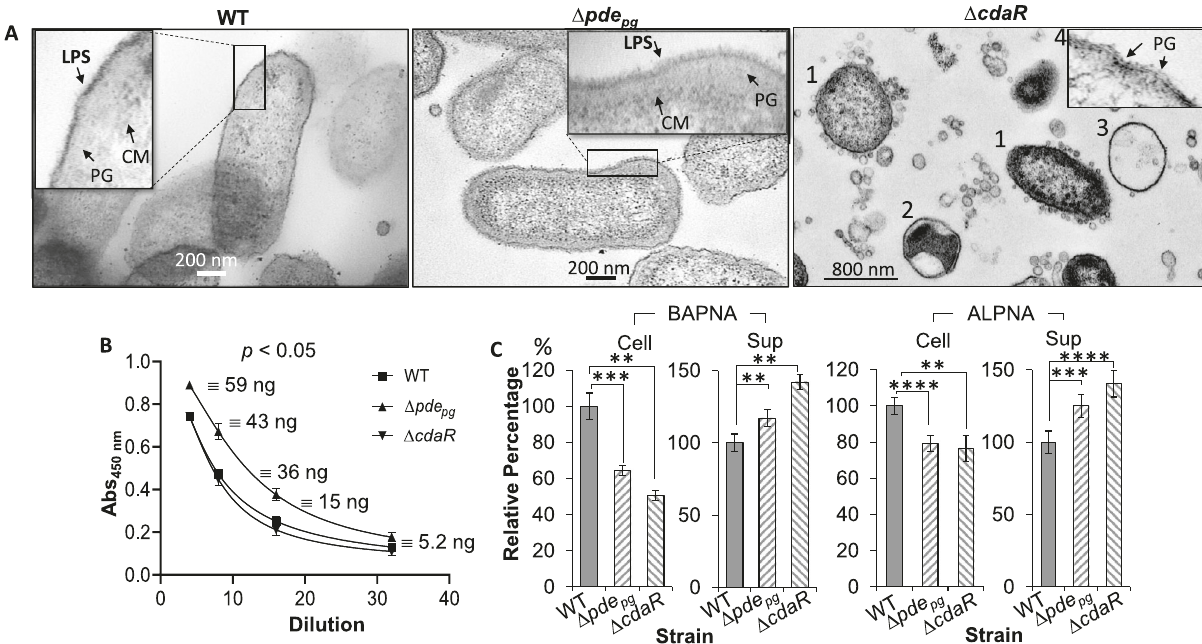
Fig. 5 Effects of defective regulation of the cellular c-di-AMP level on P. gingivalis cell envelope, the immunoreactivity of LPS, and gingipain activities. A Cells were stained with osmium tetroxide and uranyl acetate and imaged by transmission electron microscopy. Cells of Δ cdaR mutant displayed a signi fi cant shape and cell envelope heterogeneity represented by rod- and round-shaped cells with fully or partially intact cell envelopes that are overloaded with OMVs varying in shape and size (1); cells with an intact monolayer of membrane encompassing agglomerated cytoplasmic materials (2) or entirely void round-shaped structures with an intact monolayer of the membrane (3), cells displaying bare peptidoglycan layers (4). B ELISA assays of cell lysates using anti- P. gingivalis LPS monoclonal antibody. The graph represents the mean ± SE of the immunoreactivity of cell lysates (three biological replicates). The standard curve is presented in Supplementary Fig. 10. C Gingipain-dependent proteolytic activities of P. gingivalis strains cells. Graphs represent the mean ± SE (three biological replicates) of